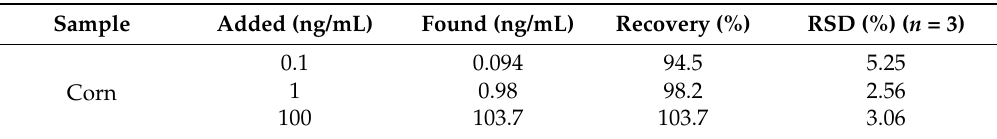
Table 3. Analysis results for determination of AFB 1 in the spiked corn